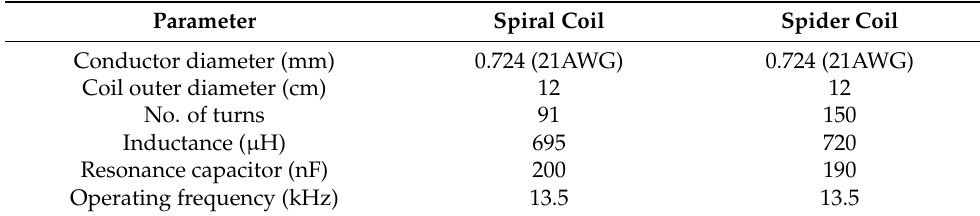
where L T and C T and L R and C R are the coil inductance and resonance capacitors of the spiral and spider coils, respectively. Table 2. The adopted parameters of spiral and spider coils. Parameter Spiral Coil Table 2. The adopted parameters of spiral and spider coils.